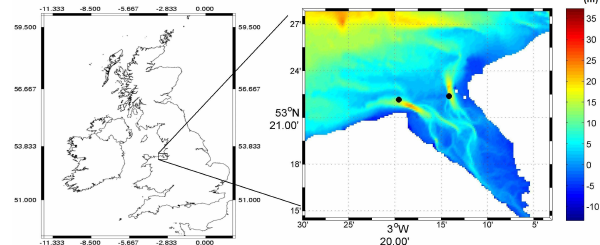
Figure 1. Location of the Dee Estuary in the Irish Sea. Right figure shows the Dee bathymetry and location of rigs at the Welsh (West) and Hilbre (East) channels. Colour scale shows water depth in me- ters, negative values represent height above mean sea